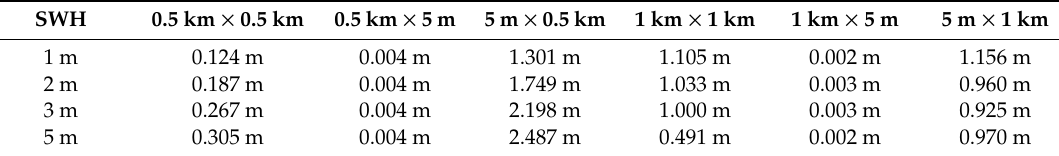
Table 15. The RMS of smoothing velocity bunching phase results with di ff erent SWH (the direction of the smoothing window is in two directions at the same time, in the azimuth and in the range).